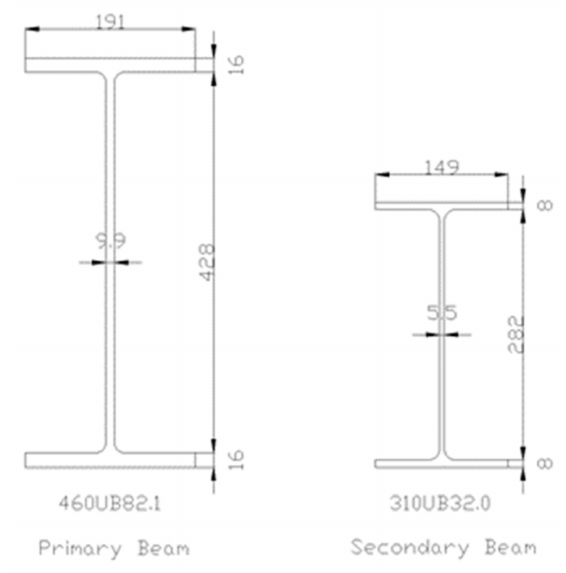
Figure 2. Dimensions of Primary and Secondary Beams.